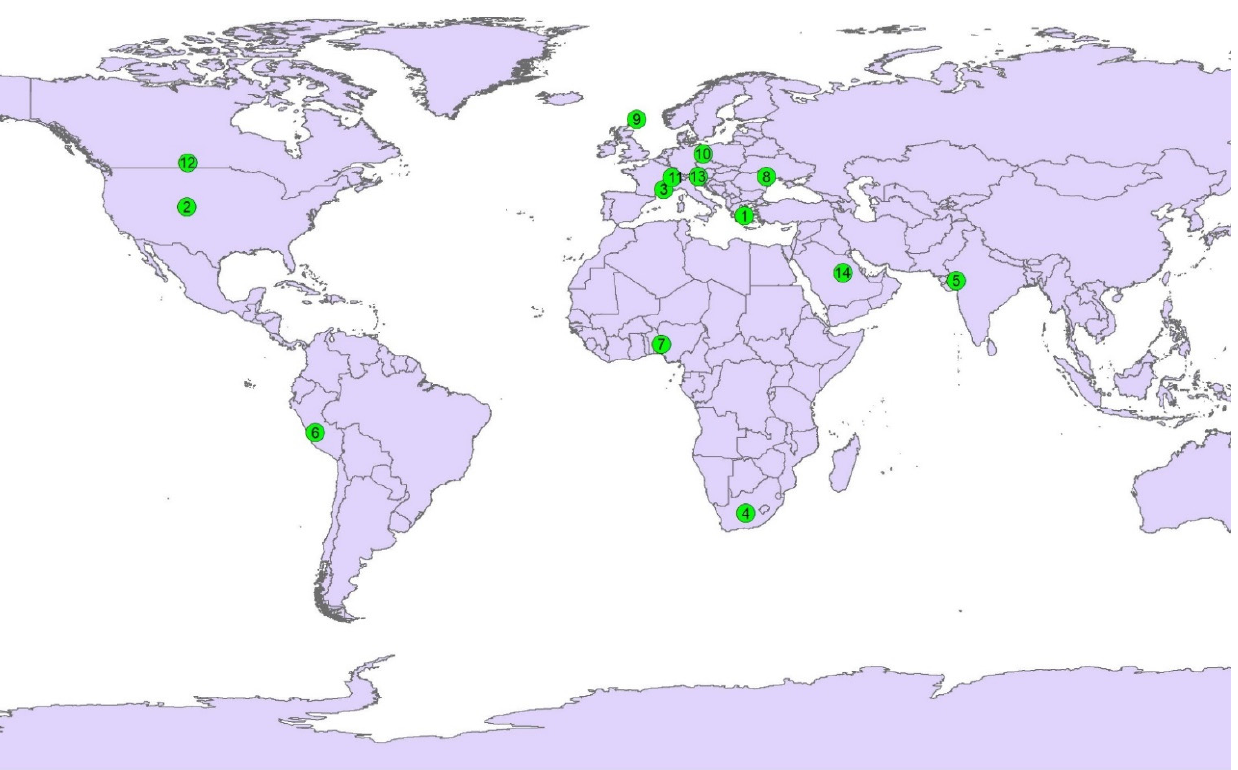
Figure 3. Location of the 14 selected sites (green circles). The numbers in the circles correspond to the numbers in column 1 of Table 1.